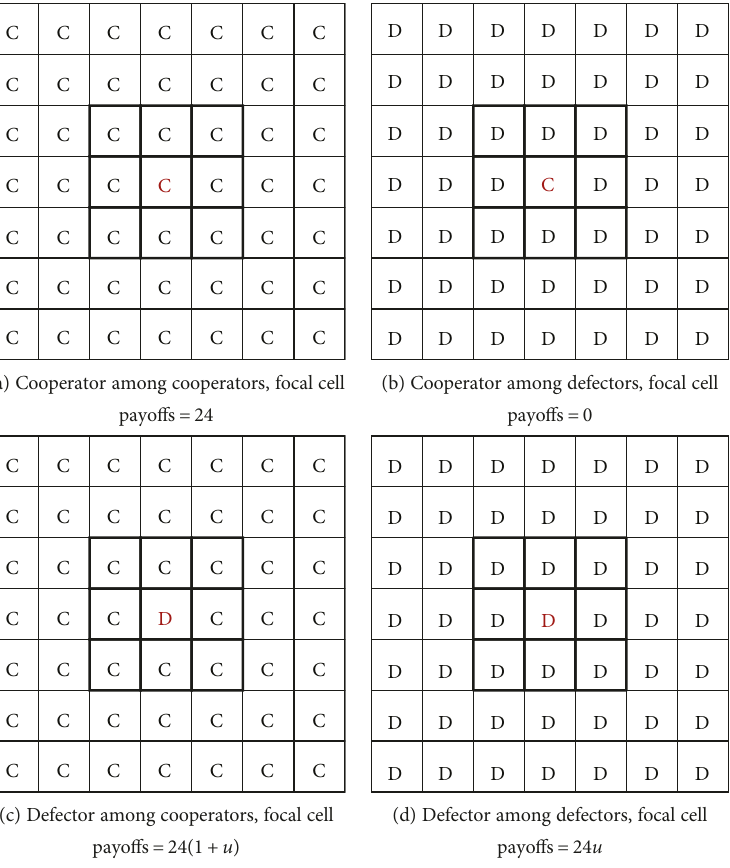
Figure 5: An illustration of a focal cell interacting with neighbors in its extended Moore neighborhood with range =3, under 4 extreme scenarios (with u < 1